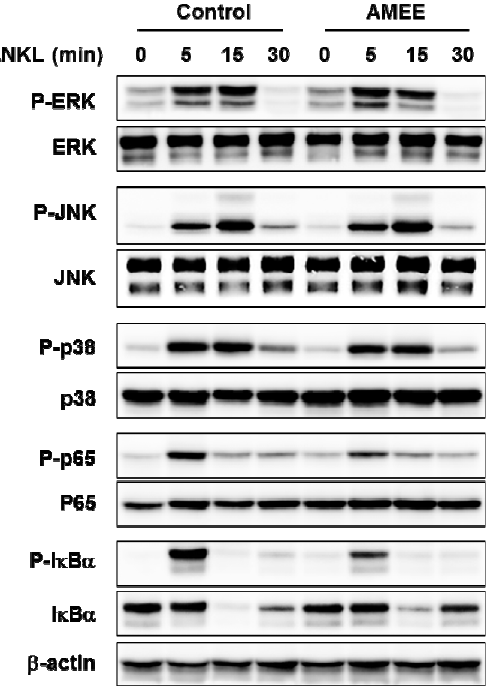
Figure 4. Effect of AMEE on the activation of MAP kinases and NF- κ B in BMMs. BMMs were pretreated with AMEE (100 μ g/mL) for 3 h and then stimulated with RANKL (100 ng/mL) for the indicated times. The total and phosphorylation levels of the indicated proteins were determined by Western blot analysis. β -actin was used as a loading